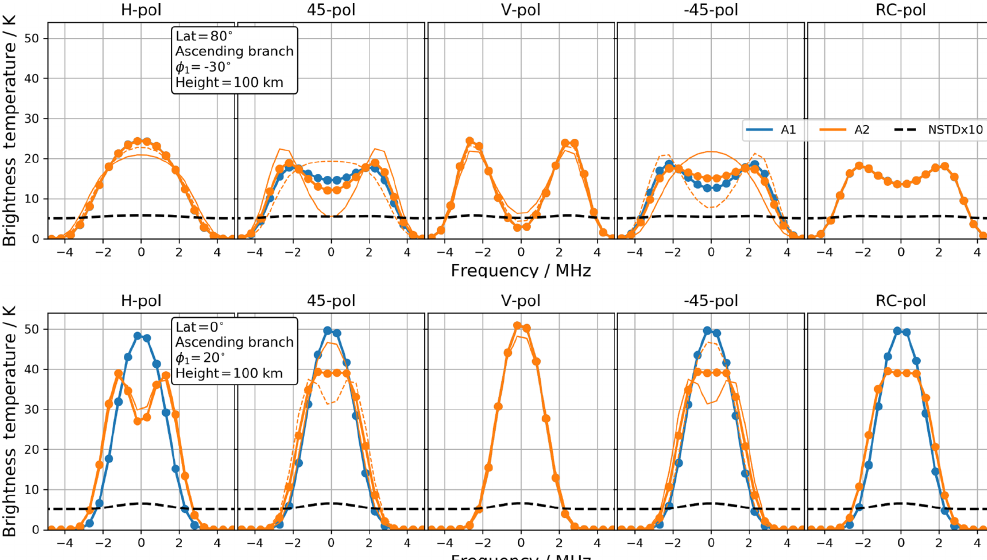
Figure 5. Upper panels: O 2 lines simulated for antenna-1 (blue) and antenna-2 (yellow) at 80 ◦ N over the ascending orbit. Panels from left to right show the results for a detector with horizontal, + 45 ◦ , vertical, − 45 ◦ and right-circular polarization. The dashed and full yellow thin lines are spectra calculated with an angular tilt of the antenna-2 detector of − 20 and + 20 ◦ . The black dashed lines are the measurement noise STD × 10 for antenna-1. Lower panels: same as upper panels but for the